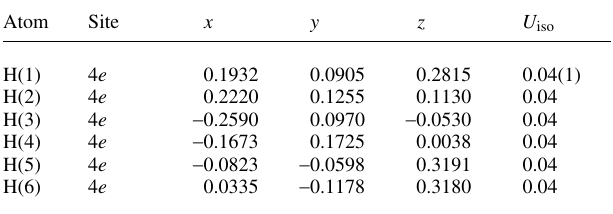
Table 14. Atomic coordinates and displacement parameters (in Å 2 ) . Table 13. Data collection and handling.